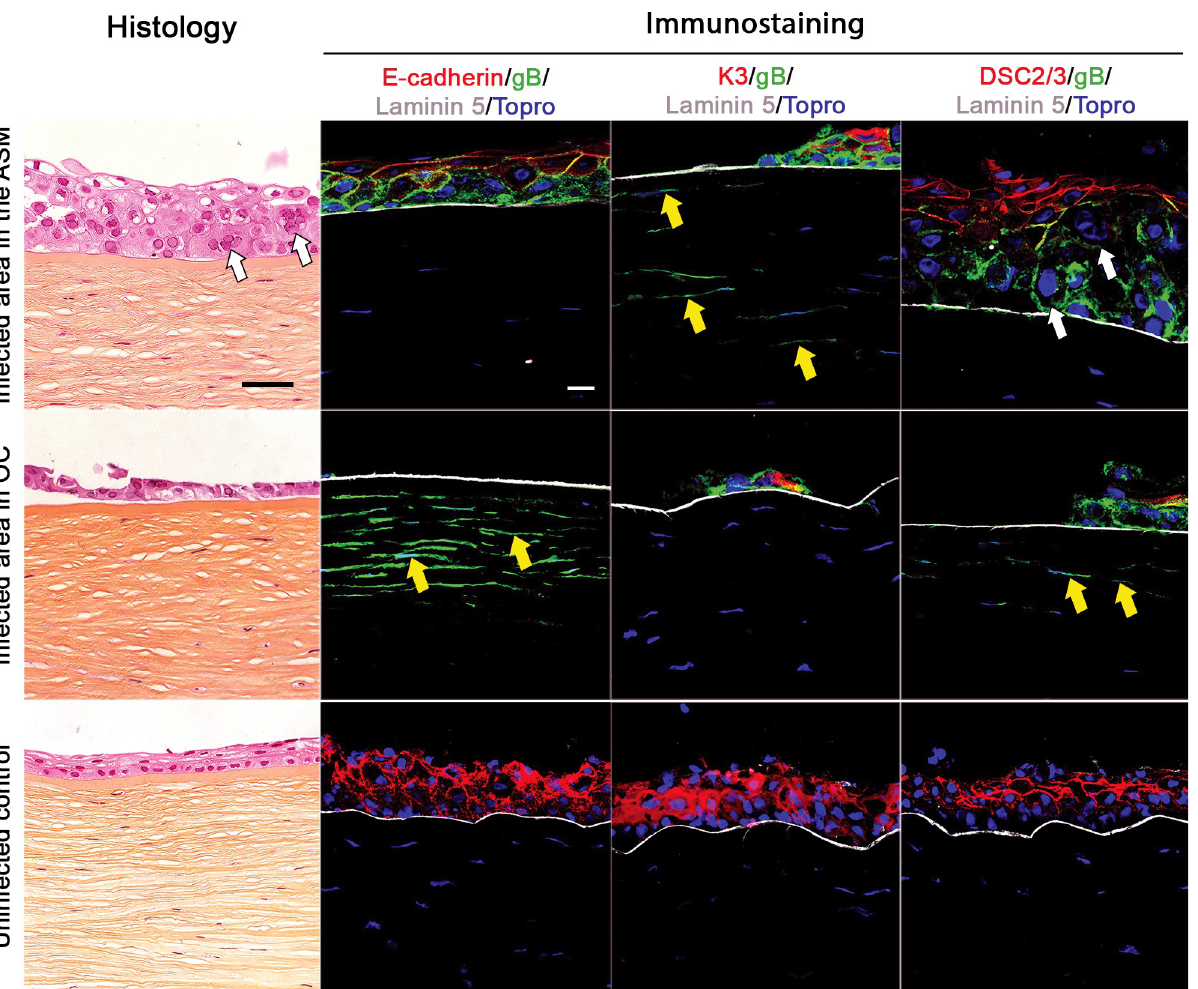
Fig 5. Cross-section of the corneal epithelium and anterior stroma after HSV-1 infection. Only infected areas are shown. Histology (hematoxylin, eosin and saffron, scale bar: 50 μ m) and immunohistochemistry of paired corneas infected in the active storage machine (ASM) or in organ culture (OC) (scale bar: 20 μ m) were compared with uninfected corneas (the ASM control group is presented here). Cells infected by HSV-1 expressed HSV-1 gB. Epithelial organization and maturation were labeled by the three epithelial markers (K3, E-Cadherin, DSC2/3), and the epithelial basement membrane integrity by expression of laminin-5. Yellow arrows mark gB+ keratocytes and white arrows marked the cytopathogenic effect (CPE) in epithelial cells. No gB staining was observed in uninfected controls. The thickness of the corneal epithelium in the ASM was greater than in passive OC because the ASM can regenerate an epithelium with more layers than in passive OC [30] and, in this thicker epithelium, the CPE further increased the difference between the ASM and OC. Nuclei were stained with To-PRO 3 Iodide.